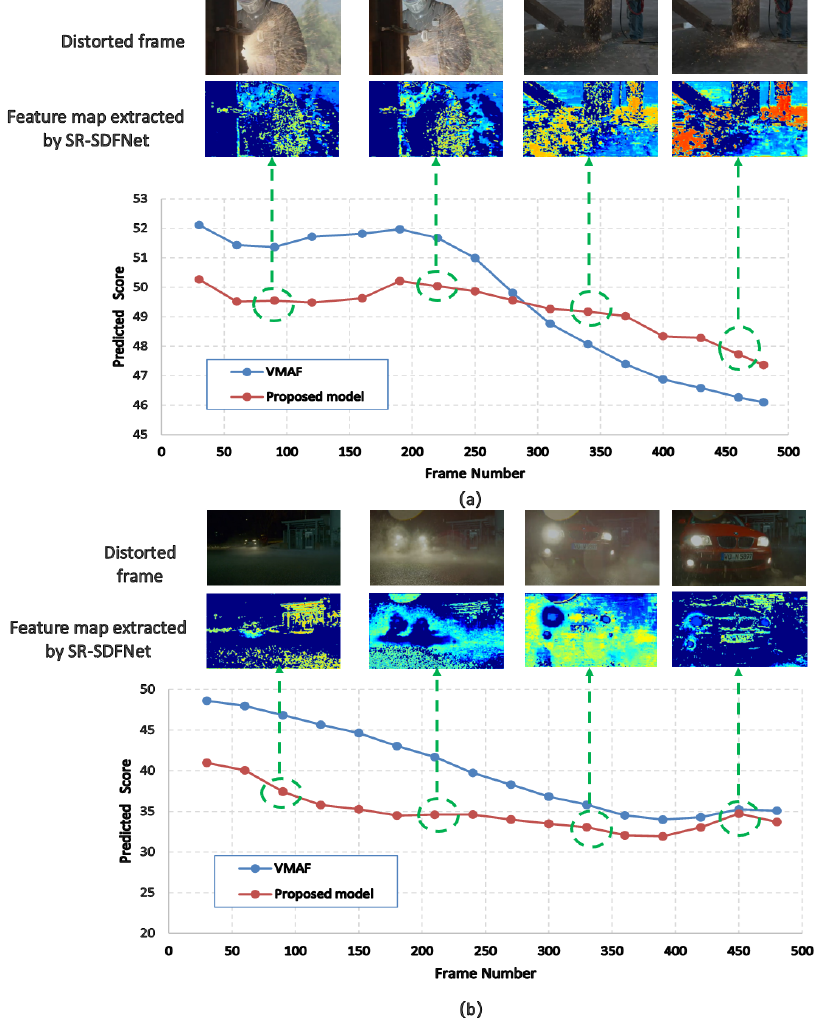
Figure 9. Two visualization examples about the prediction quality score process of our model. ( a ) and ( b ) respectively represent two distorted videos from the AVT-VQDB-UHD-1 database and curves of their predicted quality